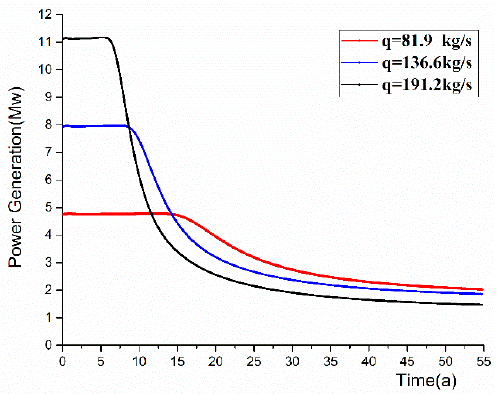
Figure 19. Predicted output power ( P e ) of three EGS cases with different injection rates.